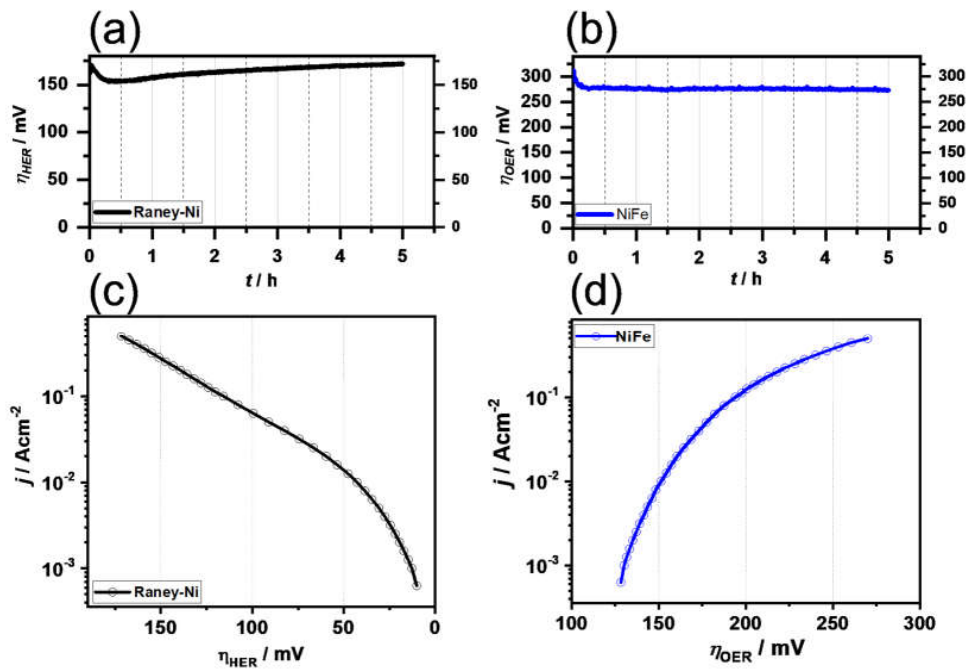
Figure 6. Galvanostatic curves for ( a ) Raney nickel and ( b ) Ni-Fe electrode, and polarization curves for an electrochemical cell using ( c ) Raney nickel and ( d ) Ni-Fe electrode, in 30 wt.% KOH solution at 333